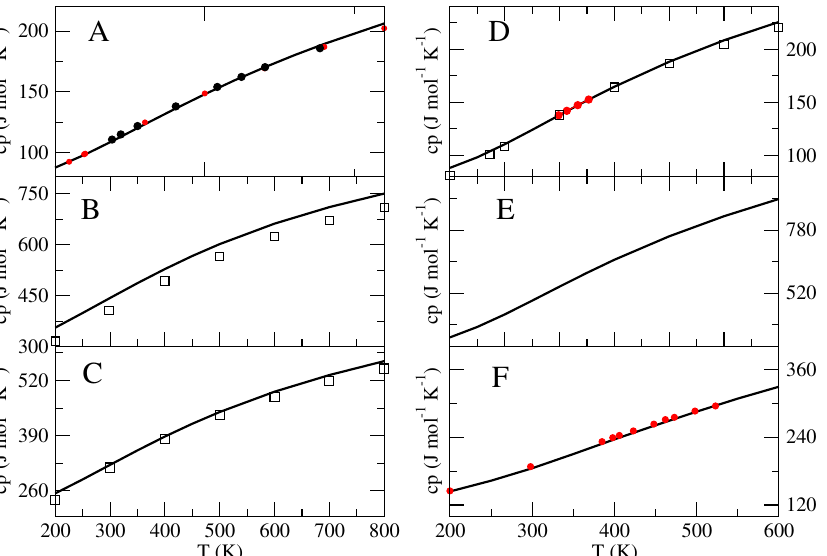
Figure 6. Comparison of the molecular isobaric heat capacity for n-butane ( A ), BmimNTf 2 ( B ), BmimPF 6 ( C ), n-butanol ( D ), octadecane ( E ) and n-octane ( F ), as provided by our equation of state (solid line). Experimental values are reported with filled red or black circles: for ( A ) from reference [31,32]; for ( D ) from reference [39]; for ( F ) from reference [40,41]. Values calculated with different theoretical-computational procedures are reported with squares: for ( B ) from reference [36]; for ( C ) from reference [37]; for ( D ) from reference